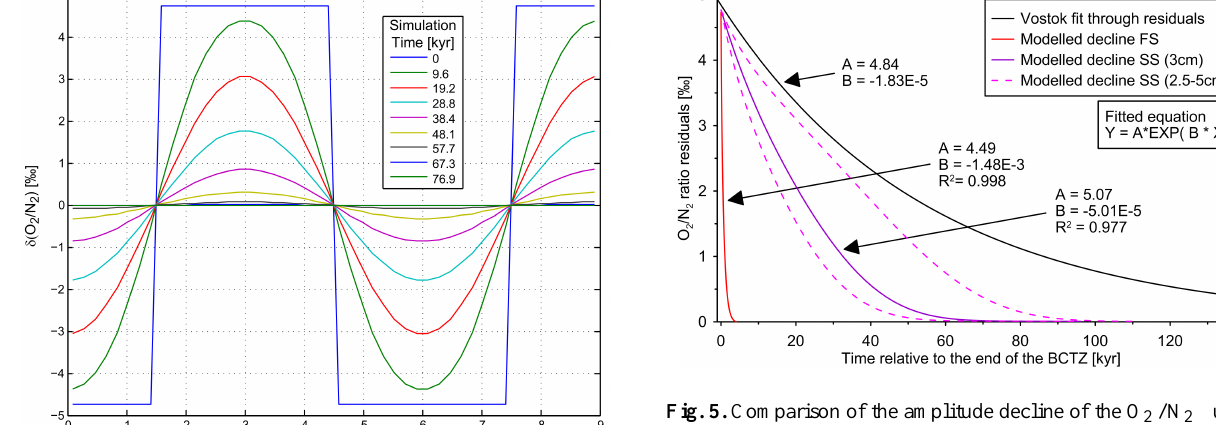
Fig. 5. Comparison of the amplitude decline of the O 2 /N 2 fluctua- tions below the BCTZ derived from the Vostok data (black line, see also Fig. 3) and the modelled decline using different parameter sets (FS or SS) and layer thicknesses. The red line shows the modelled decline using the FS and 3cm-layer thickness, the purple line shows decline using the SS and 3cm thickness and the magenta lines show the decline using the SS and 2.5cm (left) and 5cm (right) thick- nesses. The results of the exponential fit through the Vostok data as shown in Fig. 3 as well as through two modelled declines are shown for comparison (arrows indicate the corresponding